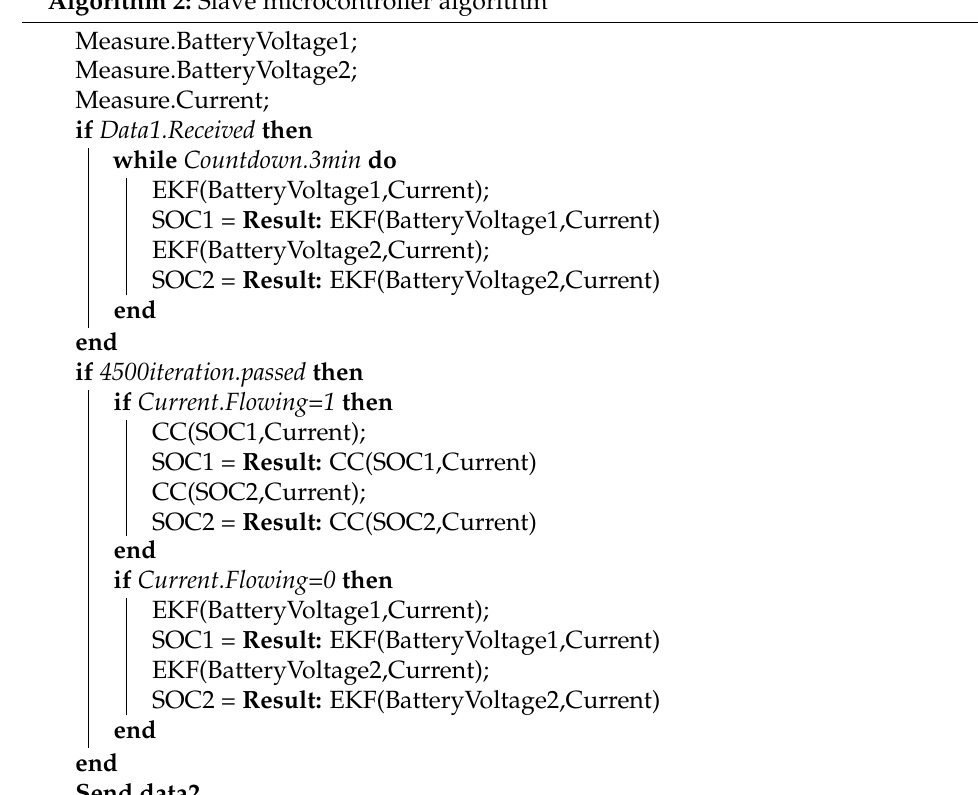
Algorithm 2: Slave microcontroller